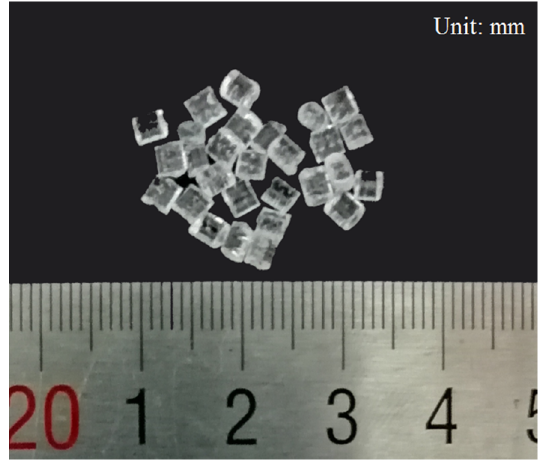
Figure 4. The amount of raw COC plasticized each time.